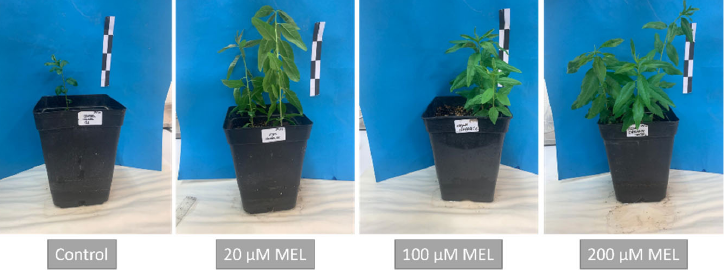
Figure 4. Representative photo of almond seedings 42 days old from primed seeds with different concentrations of melatonin (MEL), incubated in chamber A during germination (30 days) and then in chamber E (12 days). Scale: each black or white mark represents 4 cm × 1 cm.